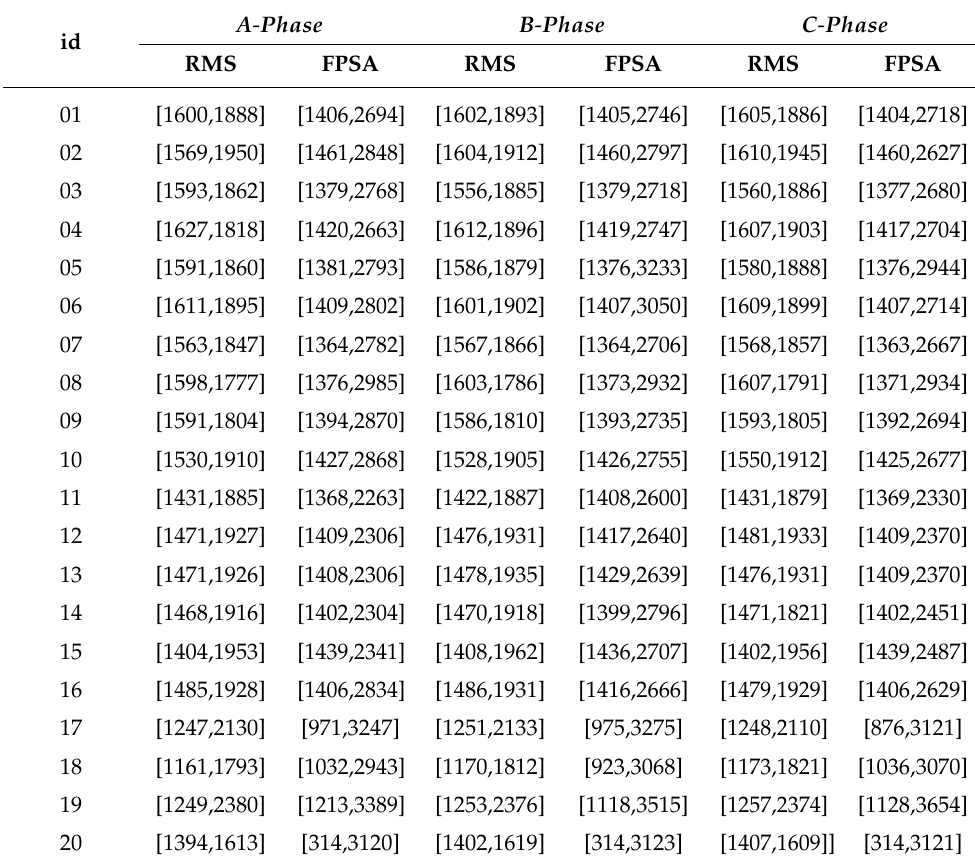
Table 2. Detection results of voltage ( [start position, stop position] ). A - Phase B - id